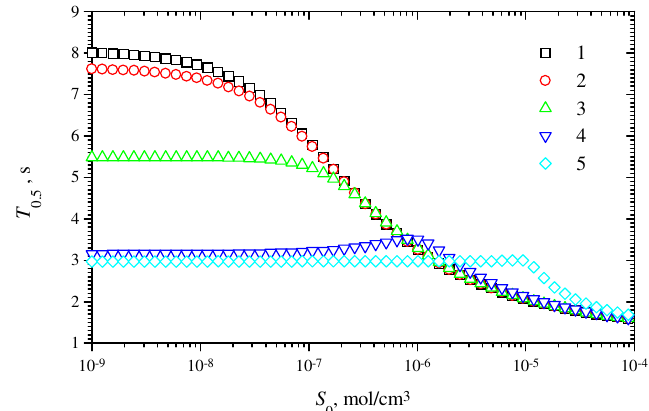
Figure 5 . The dependence of halftime T 0.5 of the maximal biosensor current on the substrate concentration S at five maximal enzymatic rates V : 10 -10 (1), 10 -9 (2), 10 -8 (3), 10 -7 (4) and 10 - 0 max 6 (5) mol/cm 3 s, other parameters are the same as in Fig.